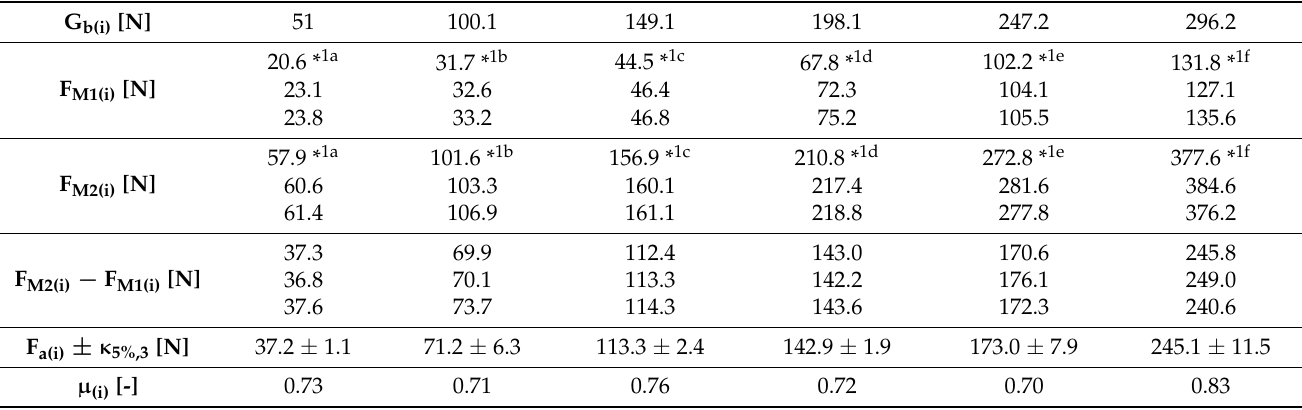
Table 2. Measured force F M1(i) [N] and F M2(i) [N] for the weight of the load G b(i) [N] at angle β = 0 deg.